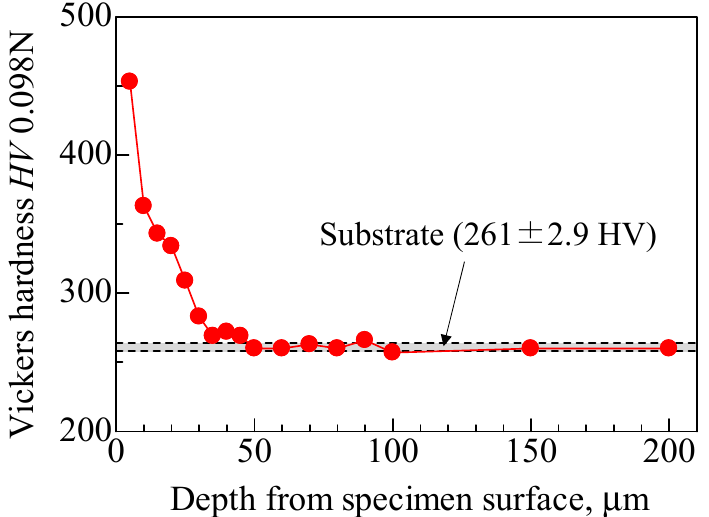
Figure 7. Distribution of Vickers hardness at various cross-sectional depths for FPP-treated specimen.